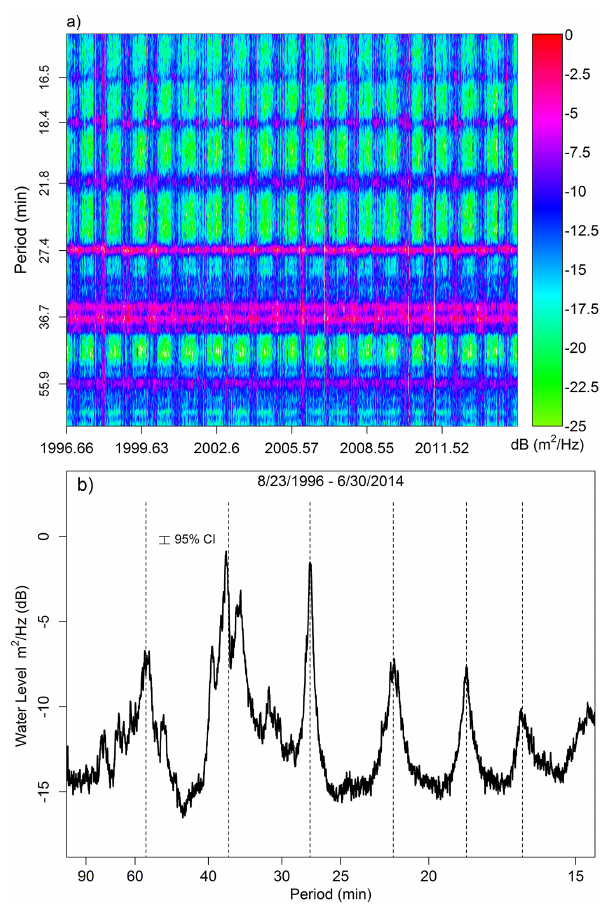
Figure 13. (a) Spectrogram of 6min water levels at the Monterey tide gauge from August 1996 through June 2014. (b) Power spectral density estimate of 6min water levels at the Monterey tide gauge from August 1996 through June 2014. Dashed vertical lines mark the bay-wide resonance modes of 55.9, 36.7, 27.4, 21.8, 18.5 and